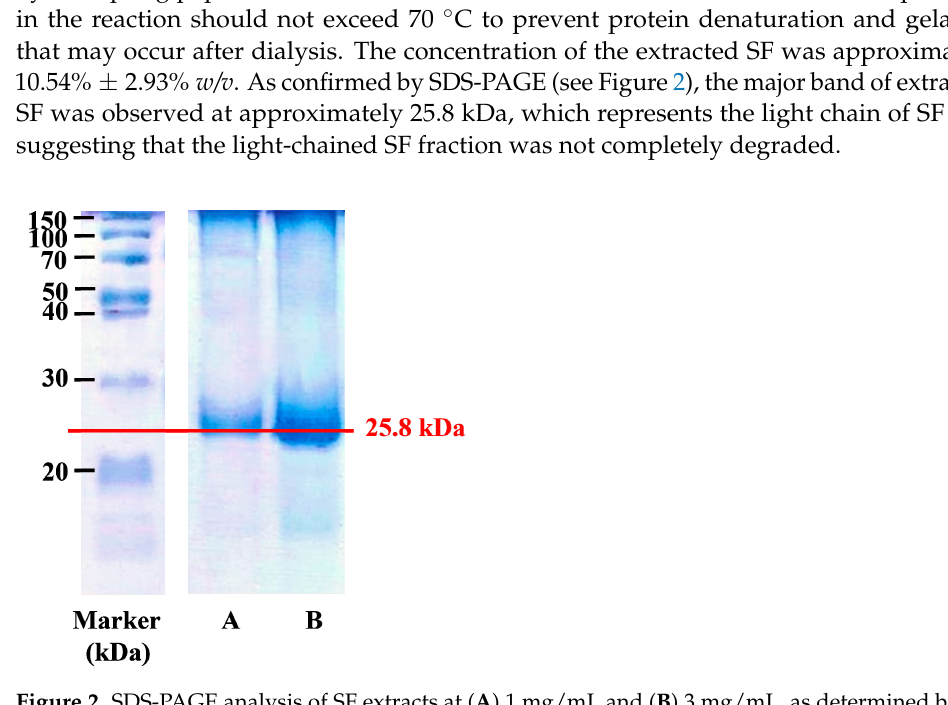
Figure 2. SDS-PAGE analysis of SF extracts at (A) 1 mg/mL and (B) 3 mg/mL, as determined by the measurement of absorbance at 280 nm. The estimated molecular weight of SF was 25.8